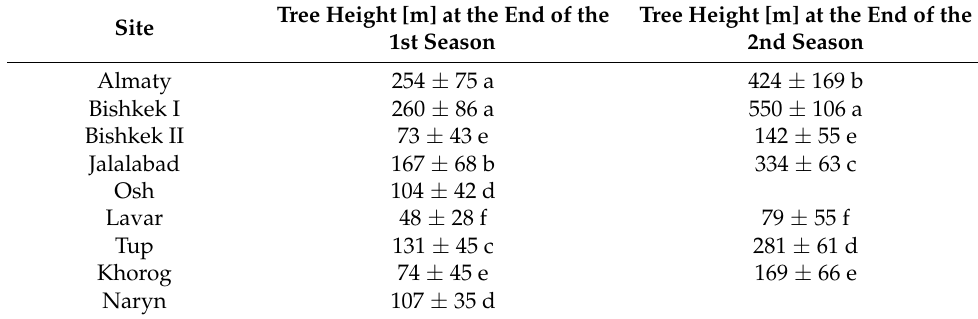
Table 6. Means ± standard deviations of tree heights [m] of all trees per site at the end of the first and second growing season. Letters here indicate groups of sites that do not differ significantly at α <